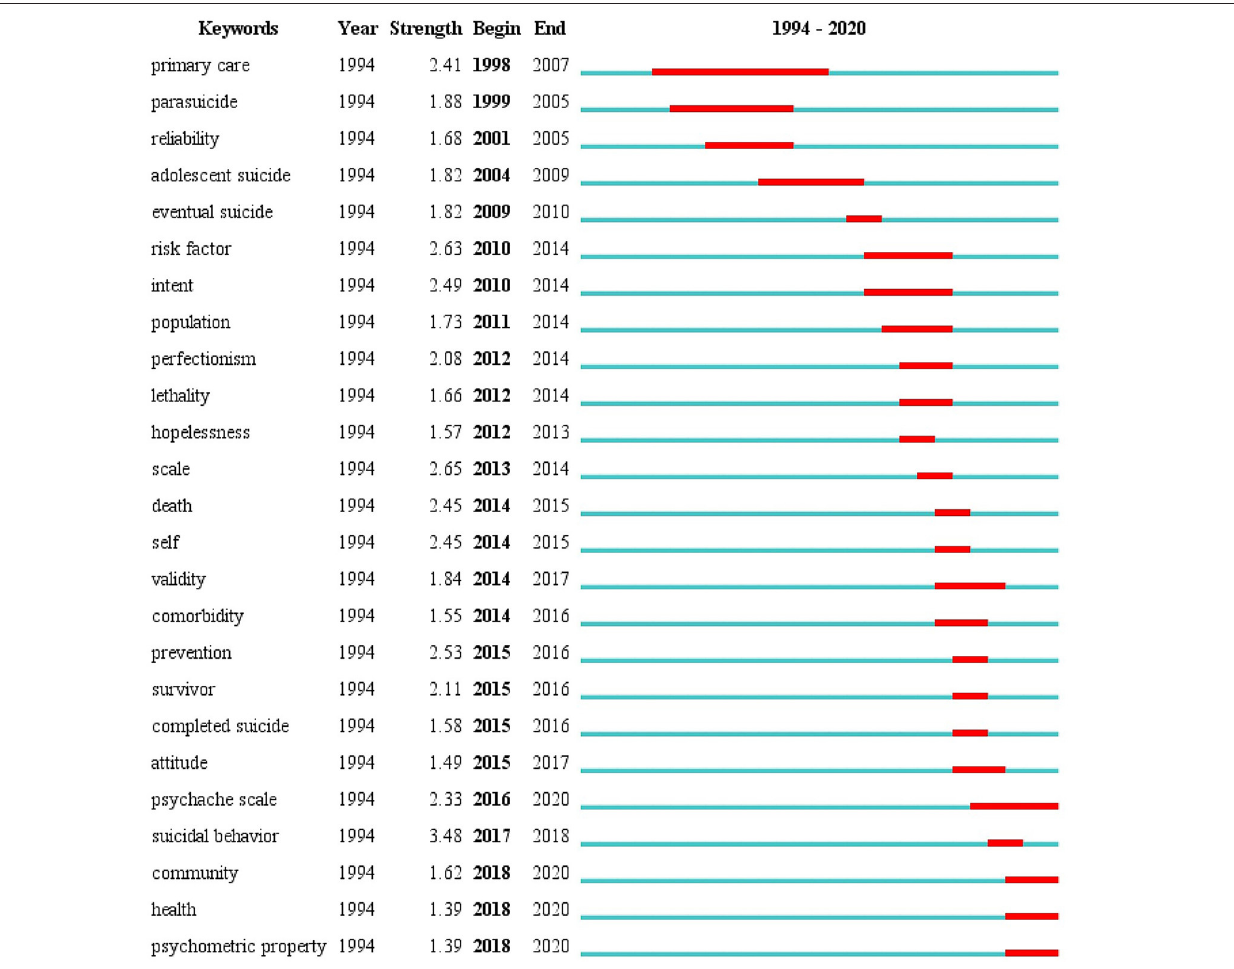
FIGURE 5 | The 25 burst terms for psychache research in the suicidology field from 1994 to